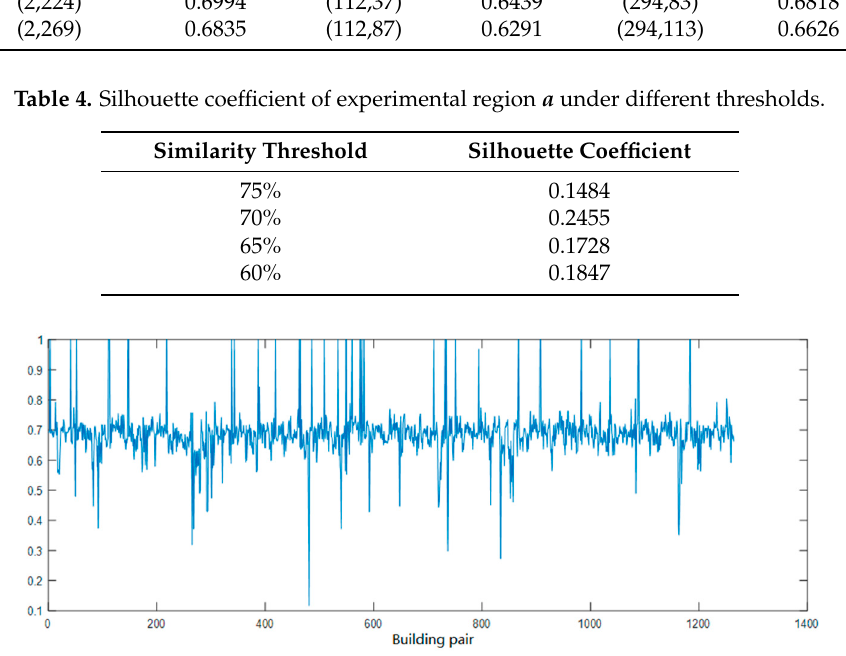
Table 3. The adjacency graph polygon model.